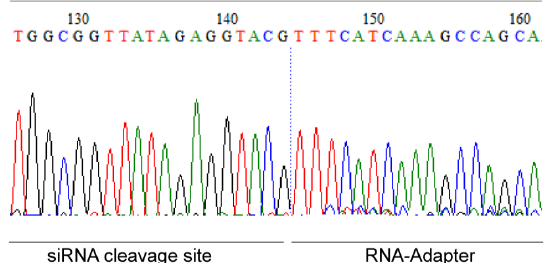
Figure 7. Sequence of 5′-RLM-RACE-PCR product (Inner PCR with Inner Primer and RACE1) of PLGA-ICAM-1 siRNA–treated EA.hy926 cells. The sequence shows the siRNA cleavage site of the ICAM-1 mRNA at bp 1818 (126–144) and the RNA Adapter sequence (145–161).